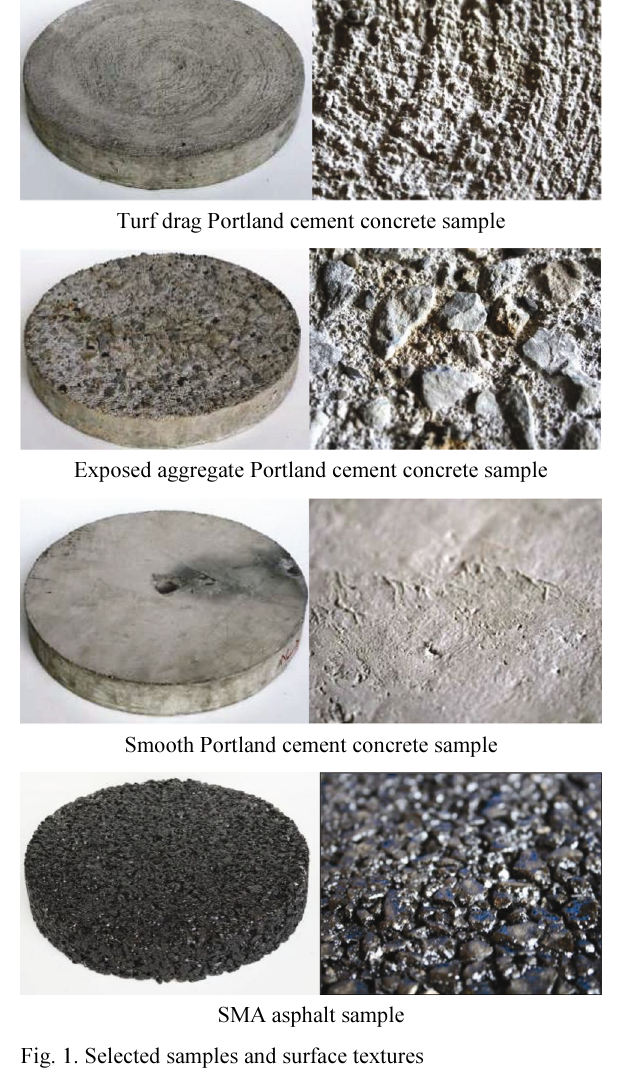
Fig. 1. Selected samples and surface